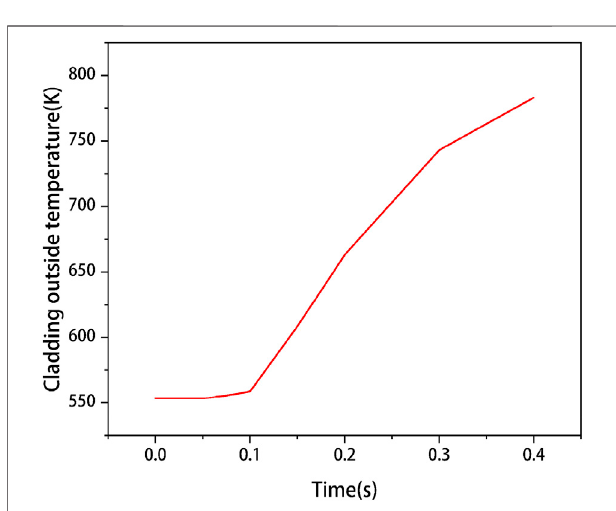
FIGURE 7 | Cladding outer surface temperature of the UO 2 fuel with Zircaloy cladding used to calculate the RIA